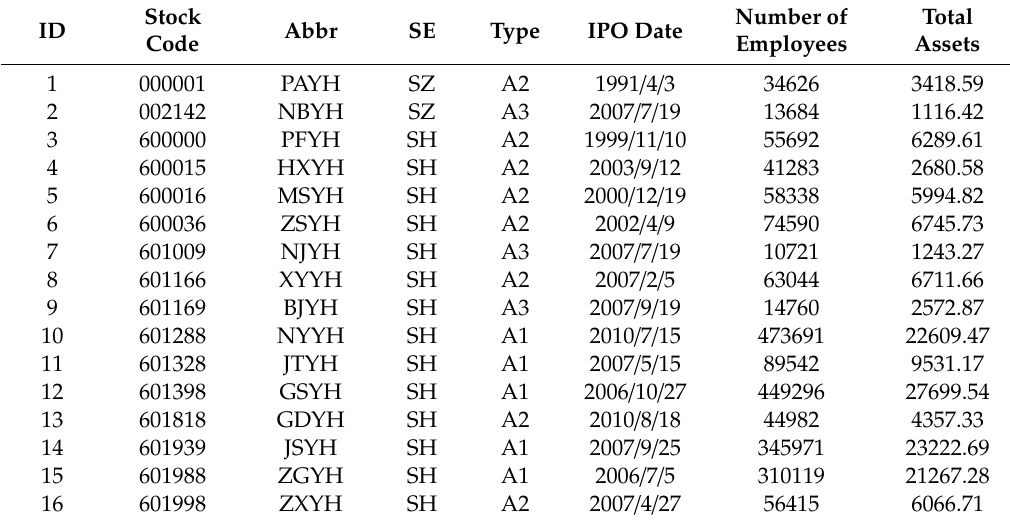
Table 4. The fundamental information of 16 sample